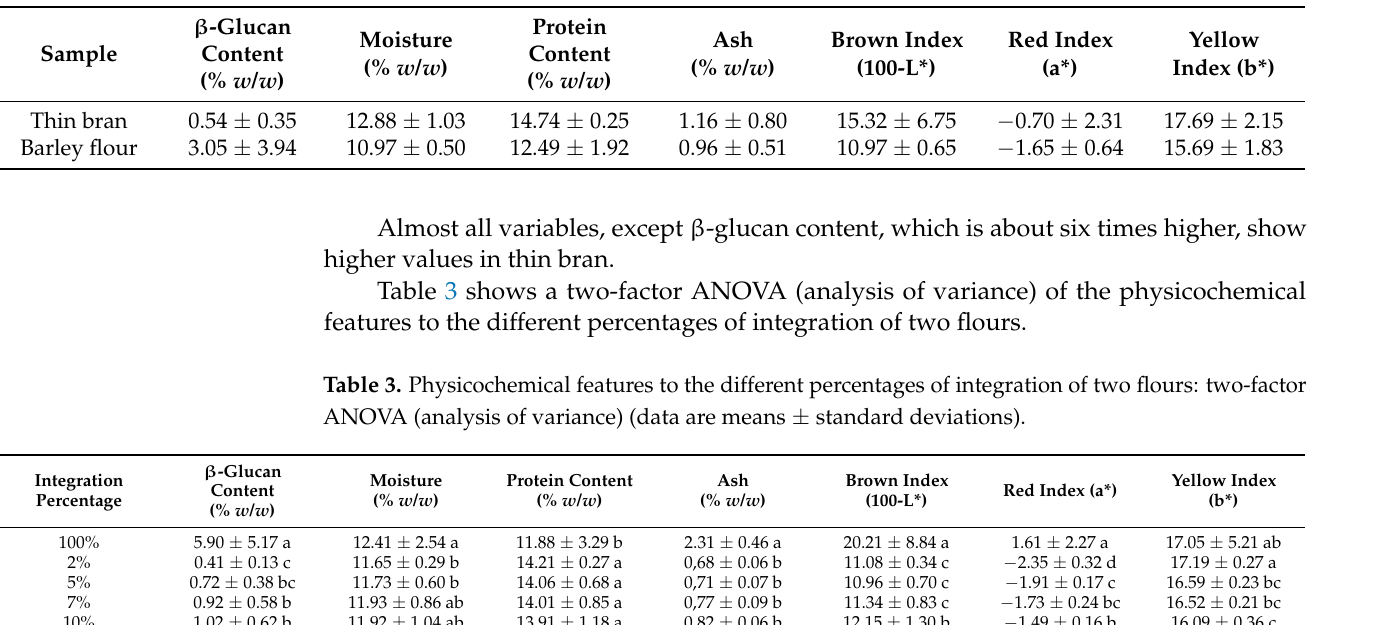
Table 2. Physicochemical features of the two flours: thin bran and barley flour: two-factor ANOVA (analysis of variance) (data are means ± standard deviations).